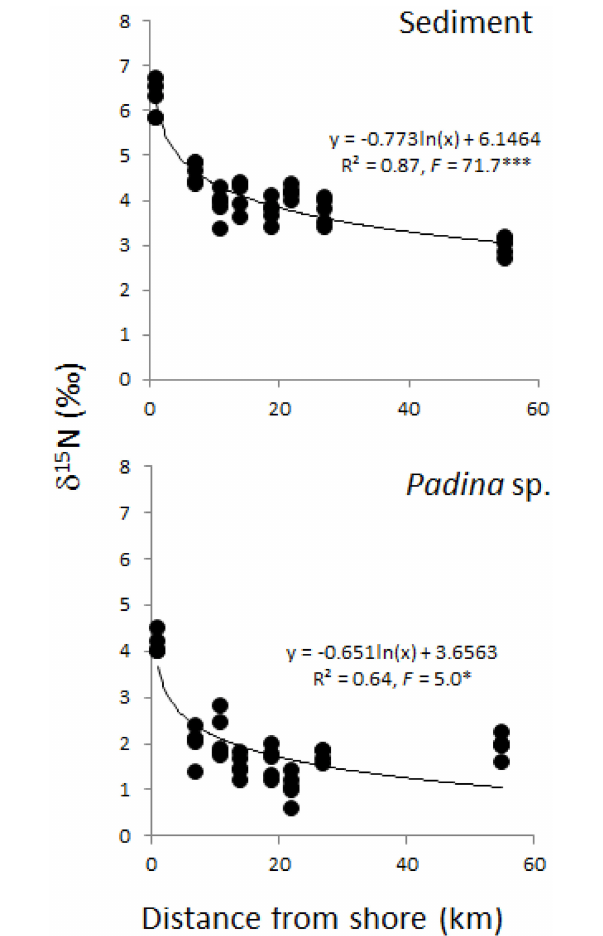
FIGURE 4 | N stable isotope values ( δ 15 N) of sediment samples and of the macroalga Padina sp. collected in 2014 at each site plotted as distance from shore (km). Asterisks indicate level of significance (*** < 0.001 and * <